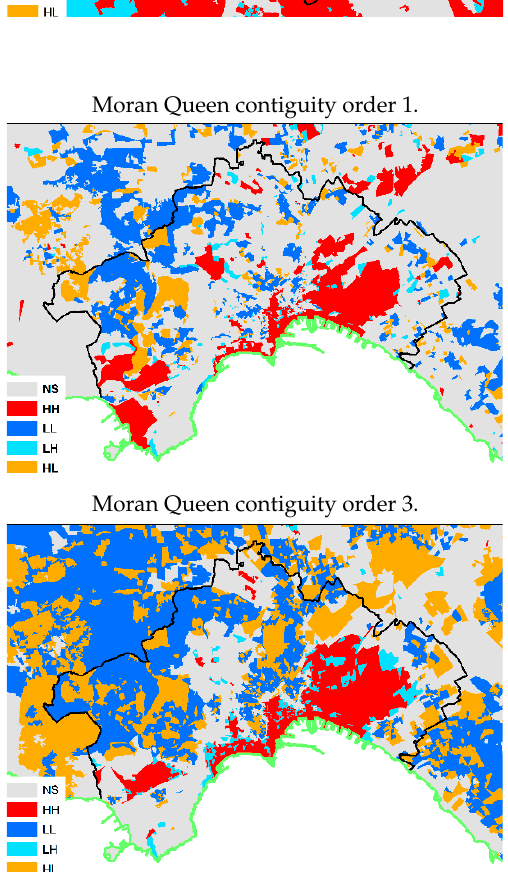
Moran Queen contiguity order 5.